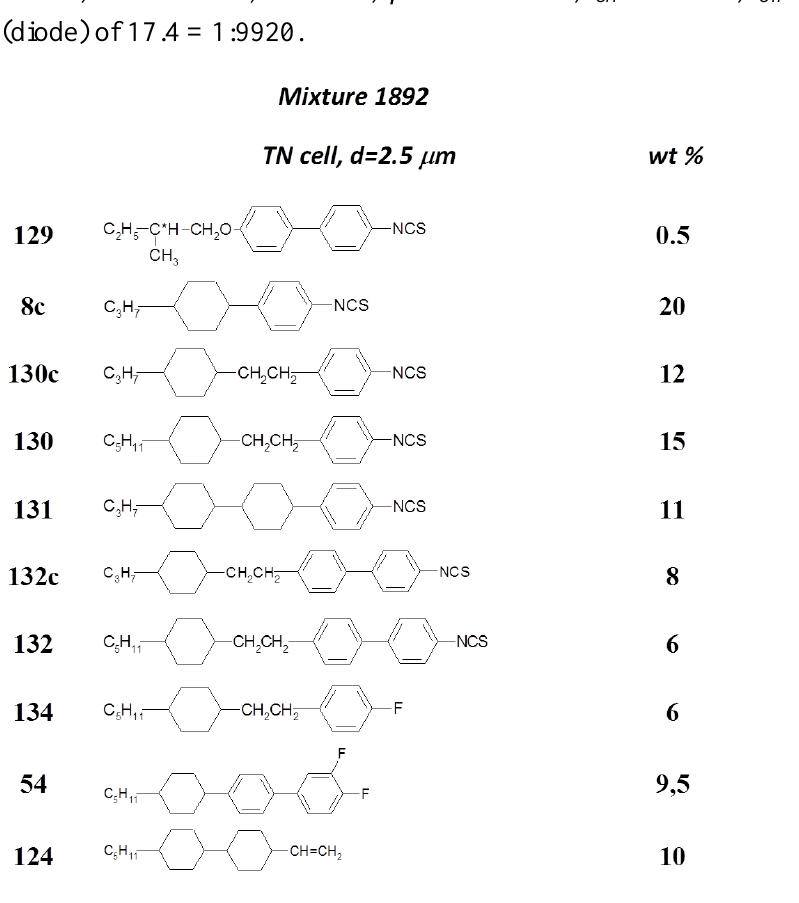
= 0.1 ms, t = 2.7 ms, on off